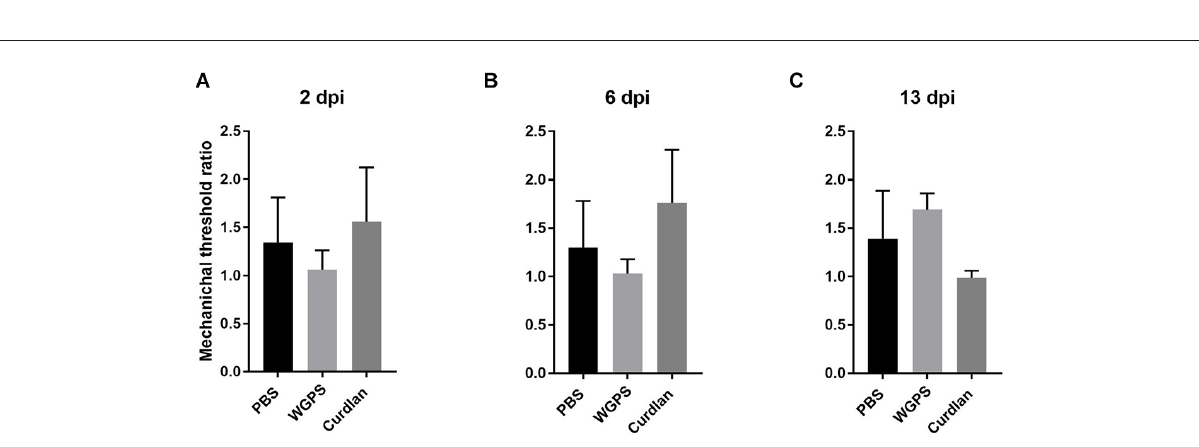
FIGURE10 Mechanical nociceptive threshold ratio of the ipsilateral side and contralateral side. (A) 2, (B) 6, and (C) 13 days after crushing injury. Mechanical threshold tests were performed 1 day before sacrifice for each group. Mechanical threshold ratios were calculated as the average mechanical threshold of the ipsilateral side divided by the average mechanical threshold of the contralateral side. There was no differences between the groups. Data are expressed as mean ± SD ( n : dpi 2: PBS n = 4, WGPS n = 3, curdlan n = 4; dpi 6: PBS n = 6, WGPS n = 3, curdlan n = 3; dpi 13: PBS n = 3, WGPS n = 3, curdlan n = 3). dpi, day